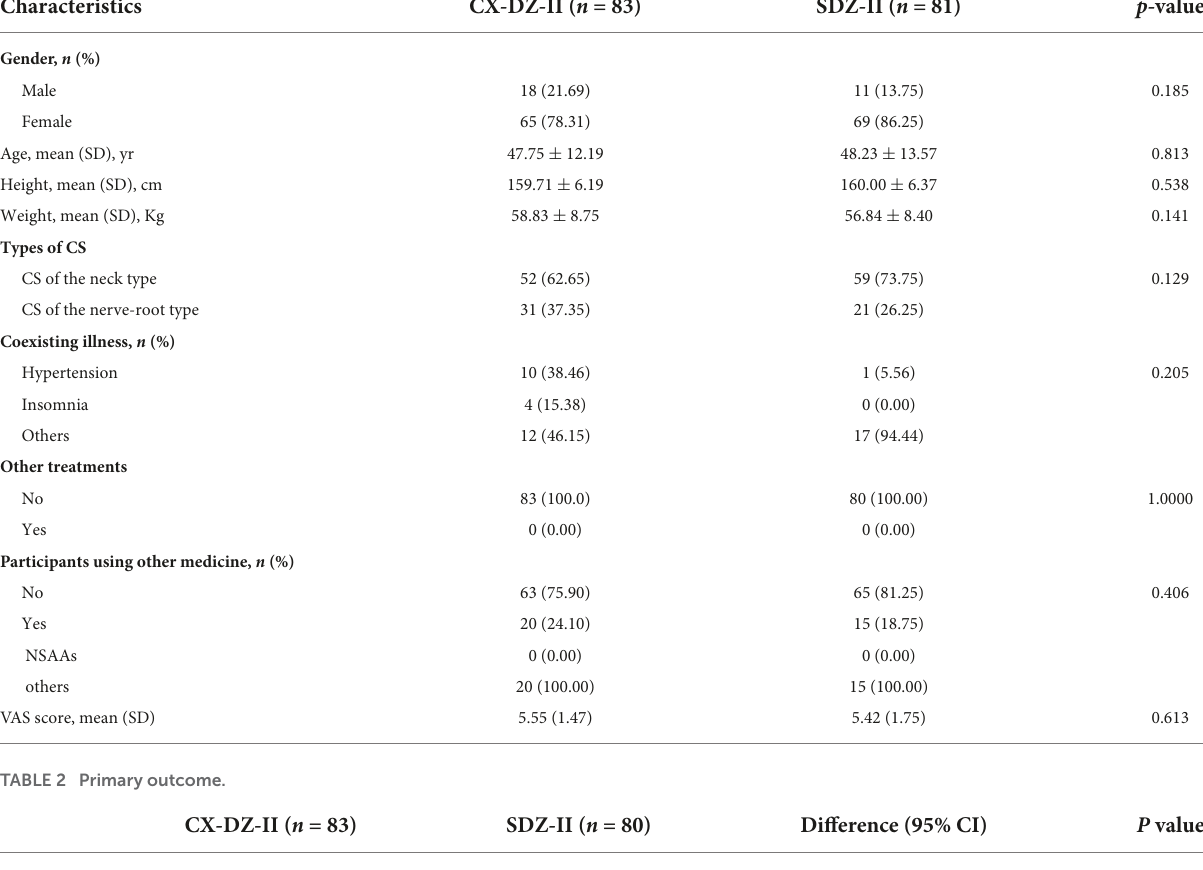
TABLE 1 Baseline characteristics.